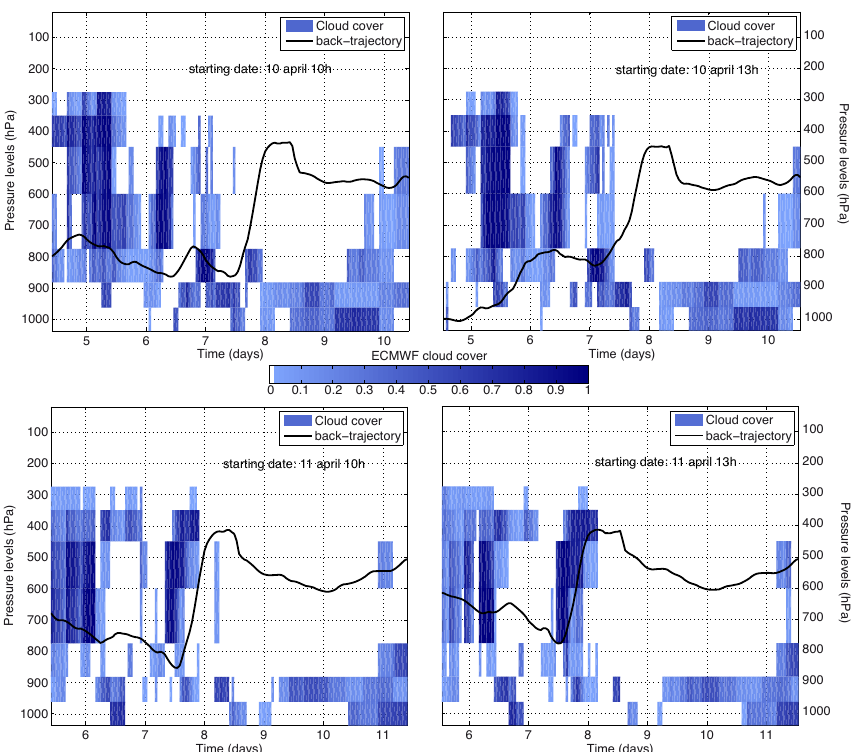
Fig. 9. ECMWF cloud cover along the HYSPLIT back-trajectories corresponding to the European anthropogenic air mass.